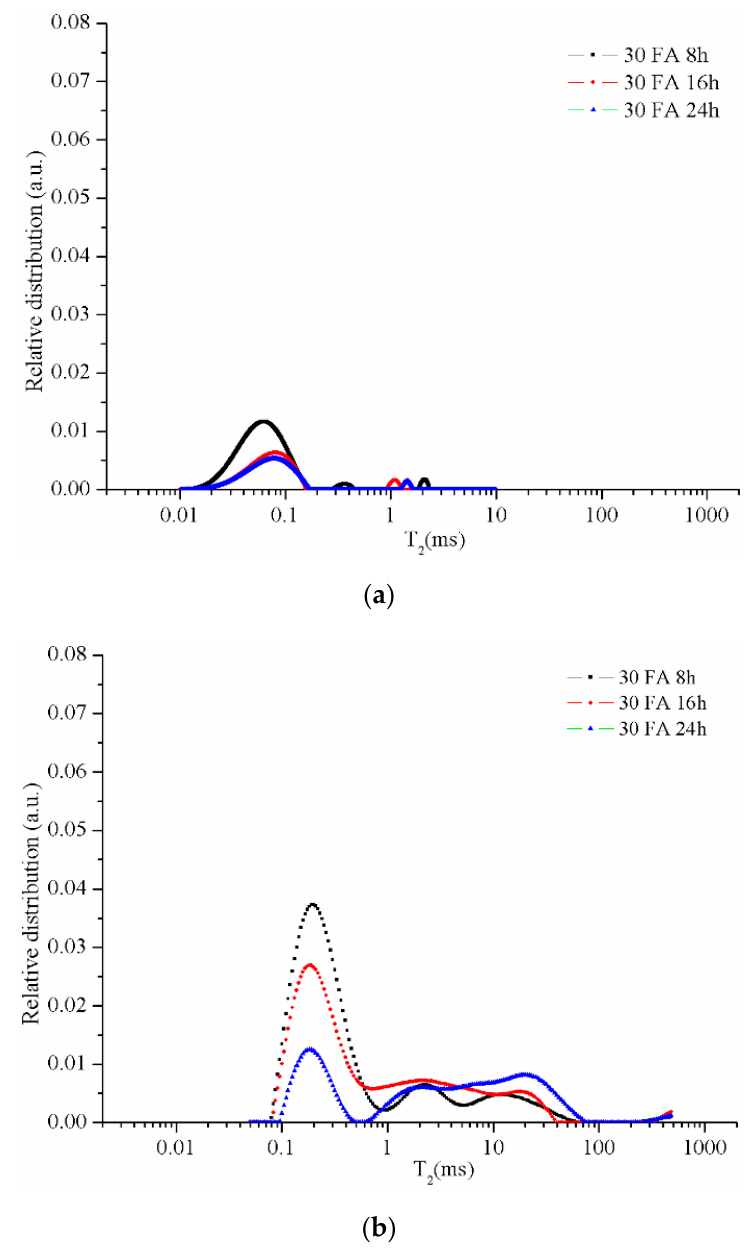
Figure 8. Relative pore size distribution in sample 30 FA dried for 8, 16, or 24 h: ( a ) after 48 days of activation and ( b ) after 7 days of immersion in water.